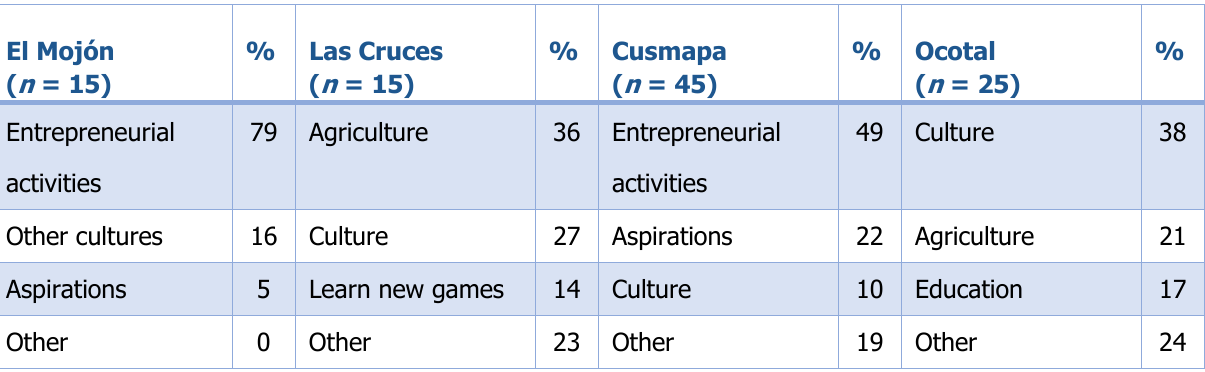
Table 2. Percentage of Responses by Each Community for the Statement: “I am curious